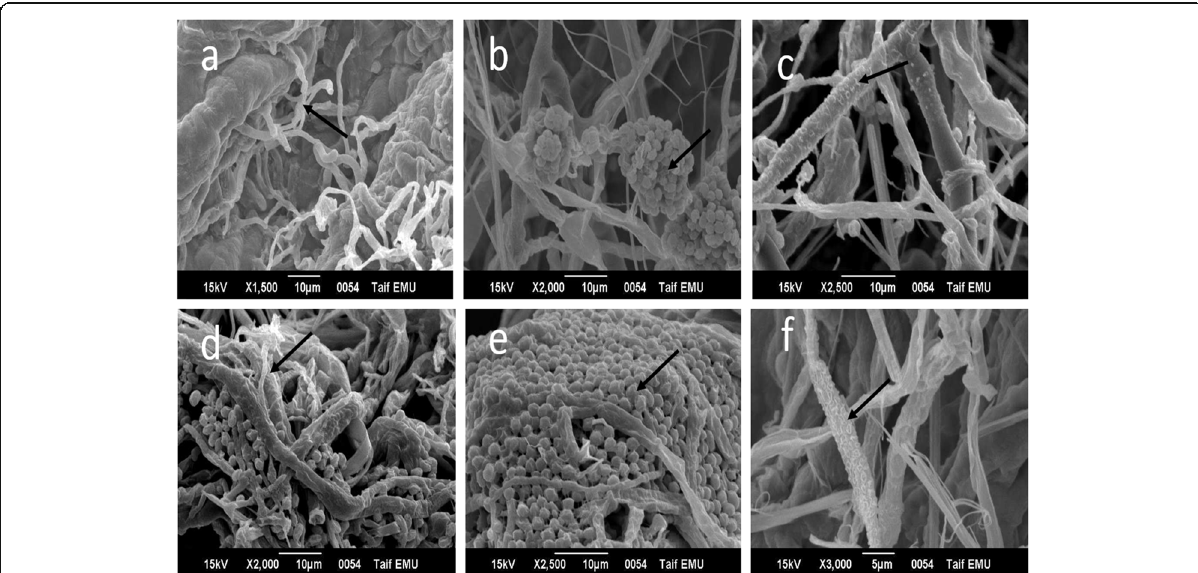
Fig. 4 Scanning electron micrographs displaying the antagonistic activity of Trichoderma harzianum isolate (T.6). a , b Coiling and spore formation of T.6 in the mycelium over Rhizoctonia solani and c , d T.6 spore formation without penetration into the cell wall and coiling of Trichoderma of Pythium ultimum . e , f Spore formation of Trichoderma T.6 over A. solani mycelia and seemed to be capable of degrading the cell walls of A.